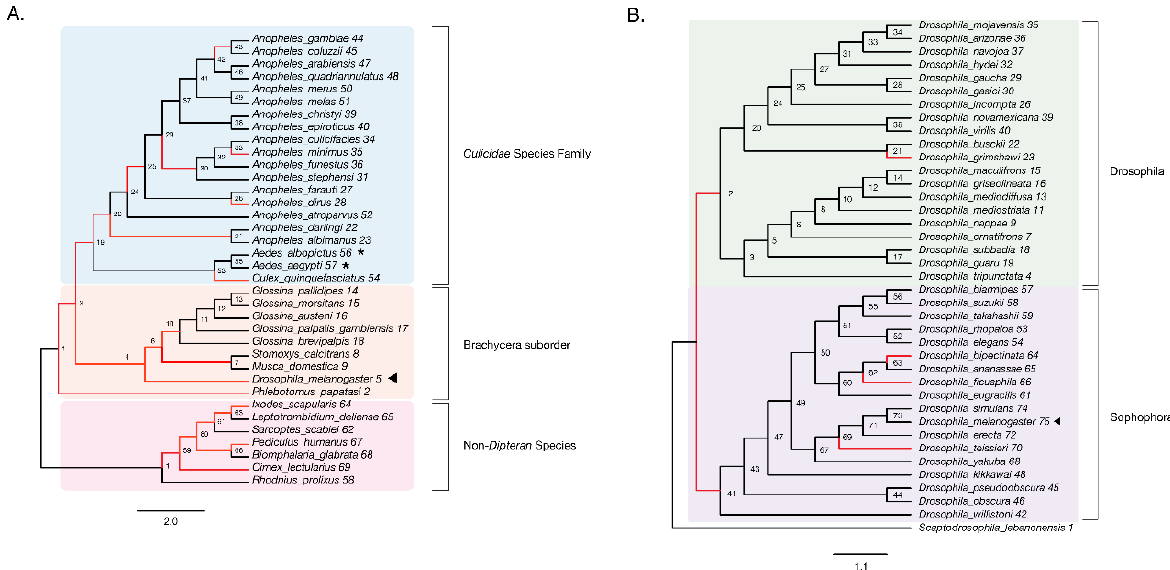
Figure 3. Evidence of adaptive evolution in DNMT2 orthologs. Branches numbered for reference in main text and Table 1. ( A ) branch-site tests were conducted to detect positive selection ( ω > 1) across lineages of DNMT2 orthologs belonging to different species within the order Diptera (clades highlighted in light blue and orange for Culicidae family and the Brachycera suborder, respectively) and non-Dipteran (clades highlighted in light pink) animals. Branches with raw p -value < 0.05 for ω > 1 are represented in red. Filled left arrow = antiviral; * = proviral ( A ) Significant evidence (see Table 1 for details) of positive selection in DNMT2 is present along branches representing multiple insect species. These include several Anopheles and one Culex mosquito species, as well as several other Dipteran fly species. ( B ) Significant evidence of positive selection is present along the ancestral branch leading to the subgroup Sophophora (clades highlighted in light purple) and along branches leading to four Drosophila species.